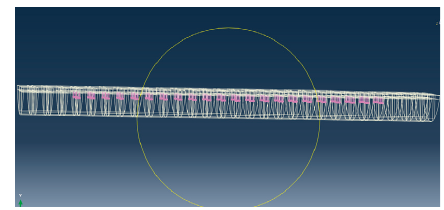
Figure 13: The load applied on the finite model. Table 4: Track bed slab and subgrad parameter values.